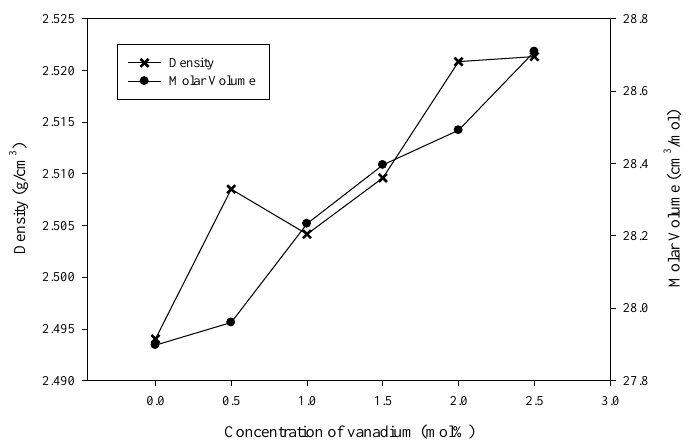
Figure 3. Density ( ρ ) and molar volume ( V a ) for (59.5– x ) B 2 O 3 –20Na 2 O–20CaO– x V 2 O 5 –Er 2 O 3 – 0.5AgCl ( x = 0, 0.5, 1.0, 1.5, 2.0 and 2.5 mol%).